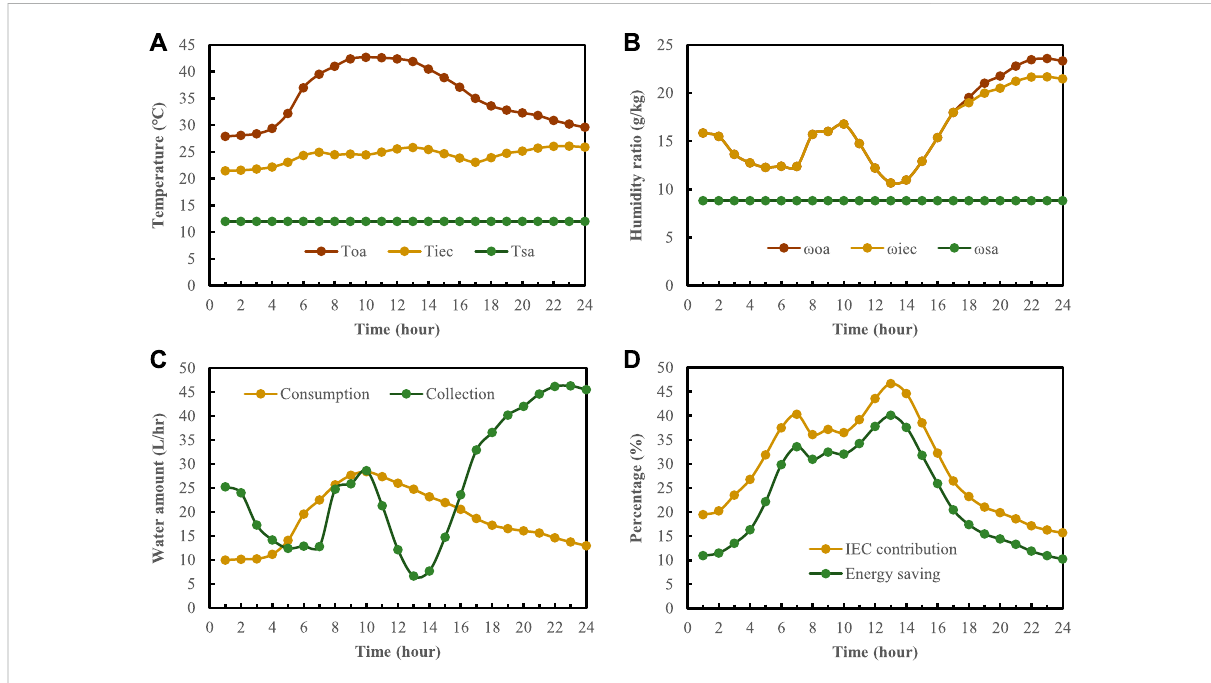
FIGURE 8 Daily performance ofIEC-MVC inDharanonJul-152021: (A) temperature change, (B) humiditychange, (C) water collection andconsumption, and (D) ∅ IEC and energy